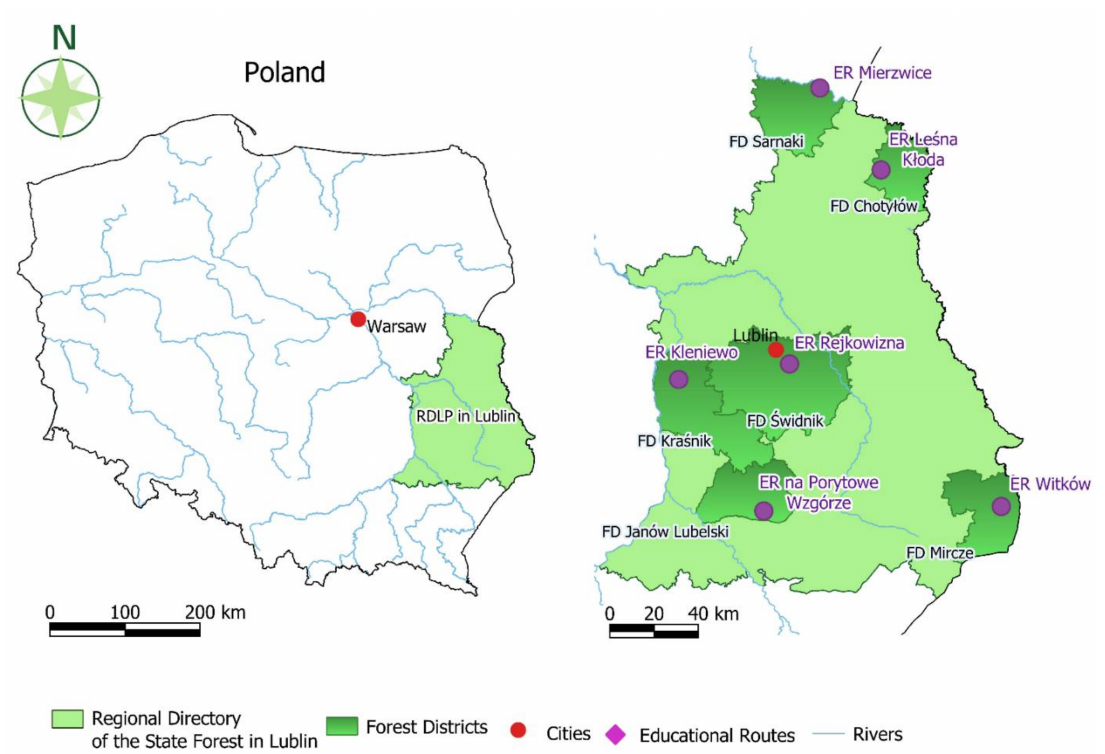
Scheme 1. Map with location of educational routes in analyzed forest